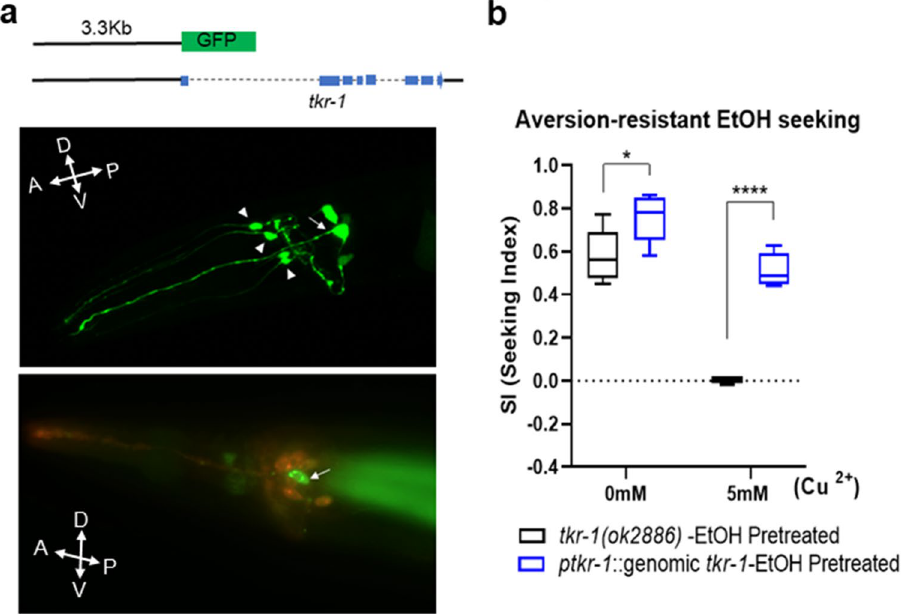
Figure 8. TKR-1 is required for compulsive ethanol seeking. ( a ) tkr-1 is expressed in the amphid neurons such as URA or CEP (arrowhead) and Amphid sheath glial cells (AMsh, arrow). Green fluorescent protein (GFP) is translationally fused with one amino acid of TKR-1 driven by 3.3 kb of 5 ′ promoter region. DiI lipophilic dye visualized the head sensory neurons (ASK, ADL, ASI, AWB, ASH, and ASJ). Using this as a marker, the amphid sheath cell was identified through its shape and location. Distinct expression in the amphid neurons such as URA or CEP (arrowhead) and Amphid sheath glial cells (AMsh, arrow) was observed. Faint expression is also observed in AIY-like and ASJ-like neurons. The double-headed arrows indicate A/P, D/V polarities. ( b ) The genomic DNA of tkr-1 containing 3.4 kb of promoter region ( a ) rescue the impaired development of compulsive ethanol seeking of tkr-1(ok2886) animals. A two-way ANOVA comparison shows [F Genotype (1, 8) = 63.44, p < 0.0001; F Concentration (1, 8) = 107.4, p < 0.0001; F Genotype×Concentration (1, 8) = 17.20, p = 0.0032]. Significant post hoc differences (Dunnett’s test) between strains are represented ( p = 0.0143,*; p < 0.0001,****).